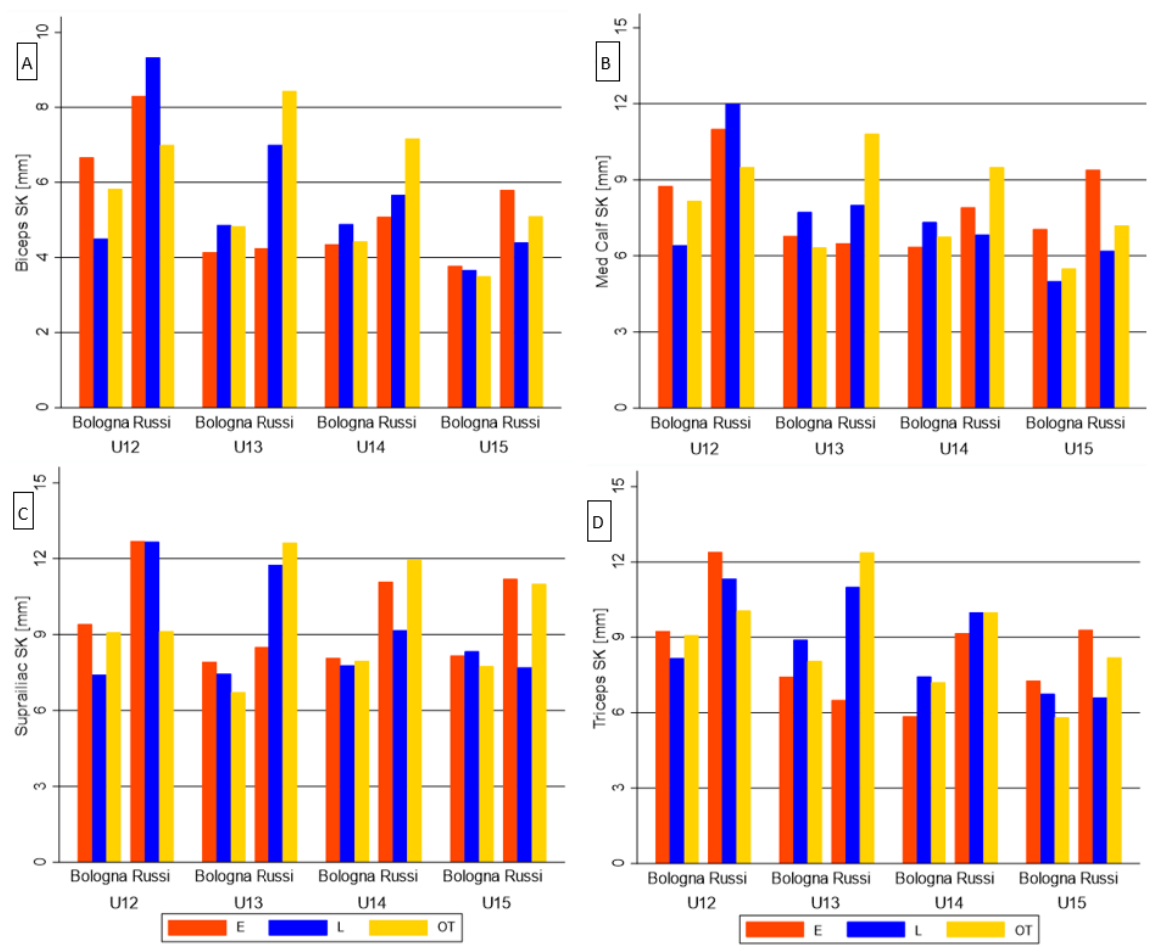
Figure 3. Bar graph of the maturity status effect on anthropometric competition level discriminants, among teams and categories: ( A ) Biceps SK; ( B ) Suprailiac SK; ( C ) Medial Calf SK; ( D ) Triceps SK.